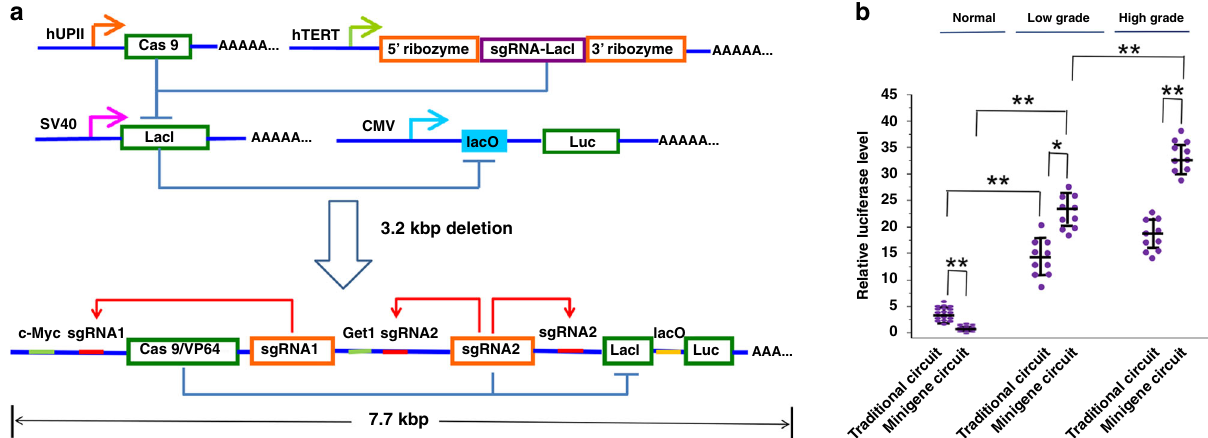
Fig. 1 Design and construction of the AND gate minigene circuits. a The UPII promoter drove the transcription of Cas9 mRNA, while the TERT promoter was used to promote the transcription of sgRNA targeting LacI. The output Renilla luciferase gene was regulated by a LacI-controlled CMV promoter. The luciferase was expressed only when both UPII promoter and TERT promoter were both activated. In the design of the minigene circuit, the UPII and TERT promoters were replaced by their respective transcription factor binding elements. Both c-Myc and Get1, only in bladder cancer cells, had a relative high expression level at the same time. After initial expression of sgRNA1 and sgRNA2, they could further bind upstream of their own transcription initiation sites and amplify the transcription signals of c-Myc and Get1 through the positive feedback mechanism to amplify their downstream genes transcription, respectively. Furthermore, the LacI gene was knocked out by sgRNA2, and luciferase reporter gene was activated by transcription. In normal bladder epithelial cells, luciferase could not be effectively transcribed and was further silenced by trace amounts of LacI expressed at the background level. b The traditional gene circuit and the minigene circuit were compared by detecting the expression levels of luciferase in different bladder cancer cells and normal bladder cells, and the cancer diagnostic ef fi cacy was analyzed. All transient transfections were performed in the presence of PGL3-TK-Fluc vector. Each experiment was independently performed in triplicate fi ve times. The small purple dots represent the relative luciferase level (Rluc/Fluc expression ratio) of each cell line, while the black lines show mean ± SD. * p < 0.05 and ** p < 0.01 between the groups using ANOVA. Exact p -values for asterisks (from left to right): 0.0038, 0.0045, 0.0018, 0.033, 0.0045, and 0.0025. Source data are provided as a Source Data fi